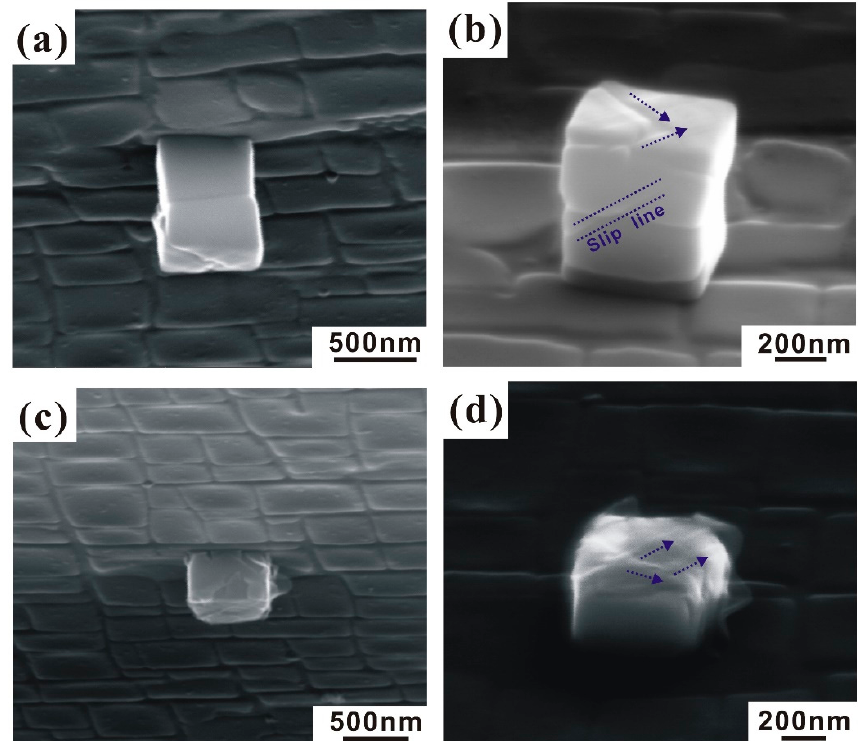
Figure 5. Slip morphologies of as-extracted Ni 3 Al nanocubes after compression. ( a , b ) Aligned cube assembly consisting of two particles; ( c , d ) long single-particle cuboid.